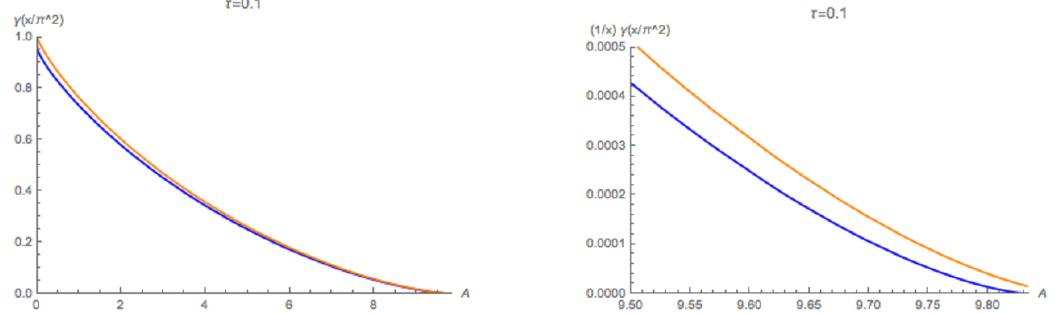
(cid:0) x (cid:1) for the deformed (blue) and undeformed (cid:25) 2 (cid:0) x (cid:1) (cid:13) for the deformed (blue) x (cid:25) 2